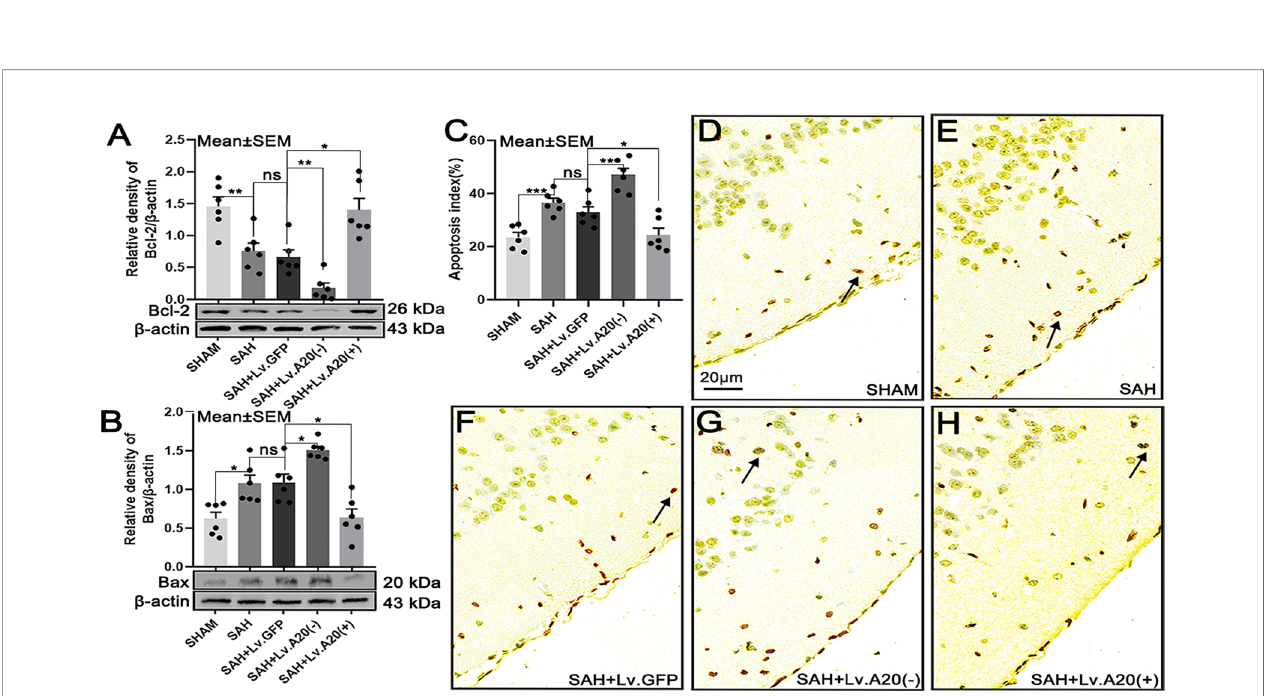
FIGURE 6 | A20 in fl uences the expression of Bcl-2 and Bax and reduces apoptosis in the cortex after SAH. (A, B) Immunoblotting images showing that A20 in fl uenced Bcl-2 and Bax expression. (C) Bar chart of the percentages of apoptotic cells displaying that A20 reduced cortical cell apoptosis (as indicated by the black arrow). (D – H) TUNEL-positive cells re fl ect cortical apoptosis. Apoptosis decreased after using lentivirus to induce A20 overexpression. Data are expressed as mean ± SEM, n = 6, * p < 0.05, ** p < 0.01, *** p < 0.005, ns versus SAH. ns, non-signi fi